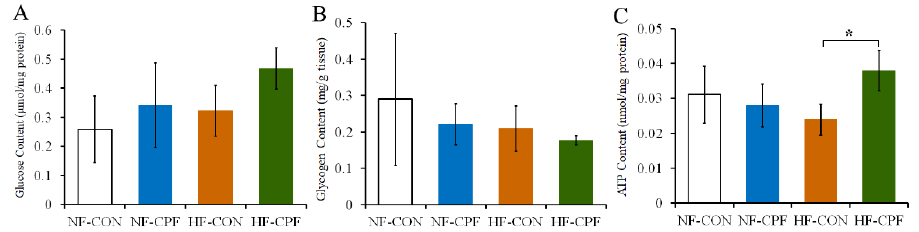
Figure 3. Effects of CPF on liver glucose metabolism of rats under NF diet and HF diet. ( A ) Glucose content. ( B ) Glycogen content. ( C ) ATP content. CPF—Chlorpyrifos. ATP—Adenosine